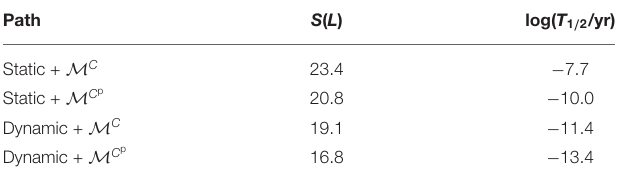
TABLE 1 | Values of the action integral (2) and half-lives for different spontaneous fission pathways shown in Figure 5 . Path